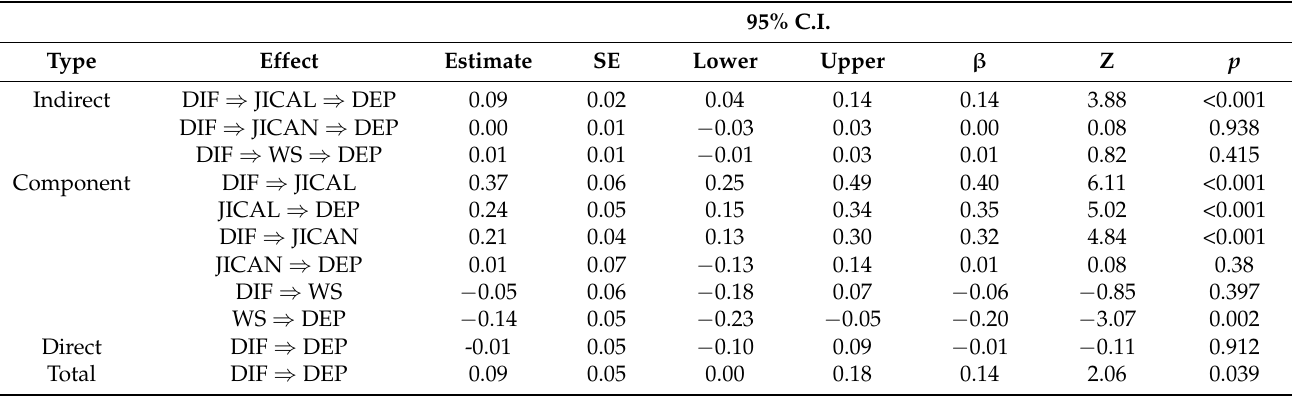
Table 5. Indirect and total effects of predictors on stress . Table 3. Indirect and total effects of predictors on